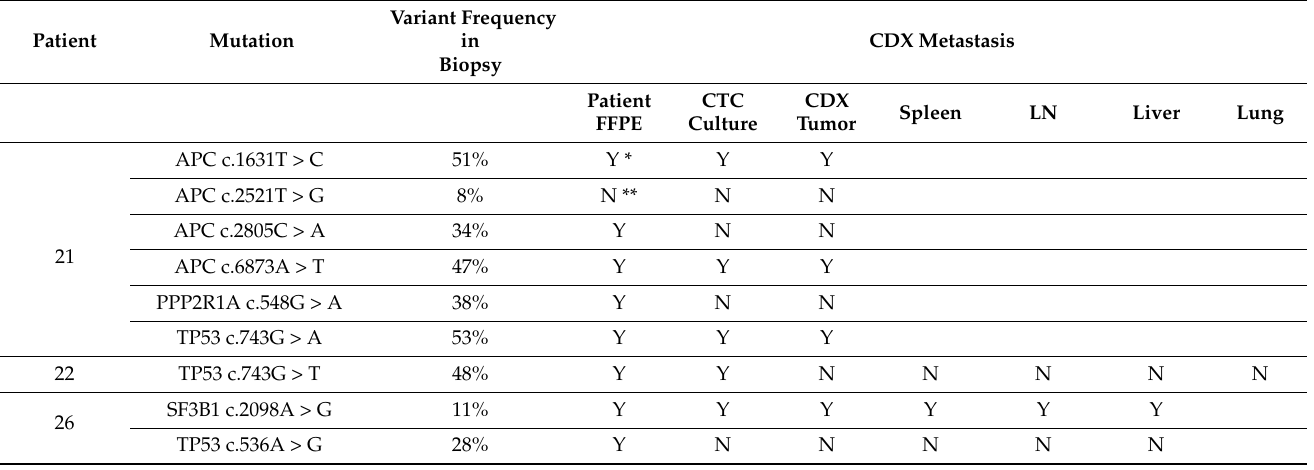
Table 1. Single-nucleotide polymorphisms were compared between clinical samples of patient pri- mary tumor biopsies and corresponding FFPE, CTC cultures, CDX tumors, and CDX metastatic